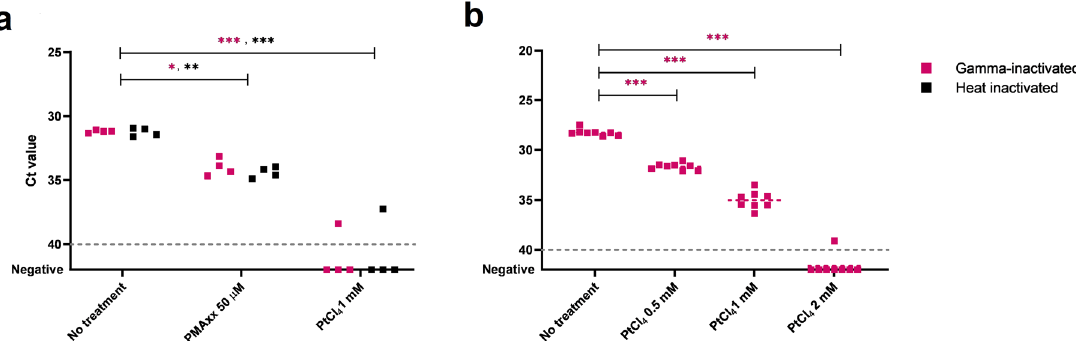
Figure 2. Assessment of viability markers on inactivated SARS-CoV-2 viral particles suspended in PBS buffer at different concentrations. RT-qPCR assays targeted N1 region. ( a ) Comparison of PMAxx and platinum chloride (PtCl 4 ) viability RT-qPCRs on low (ca. 10 3 gc/mL) gamma- and heat inactivated SARS-CoV-2 viral particles. ( b ) Viability RT-qPCR optimization using increasing concentration of PtCl 4 on high concentrations of gamma- inactivated SARS-CoV-2 viral particles (ca. 10 5 gc/mL). Dashed grey lines represent RT-qPCR theoretical limit of detection. Asterisks indicate significant difference from untreated control: * p < 0.01; ** p < 0.001; *** p <